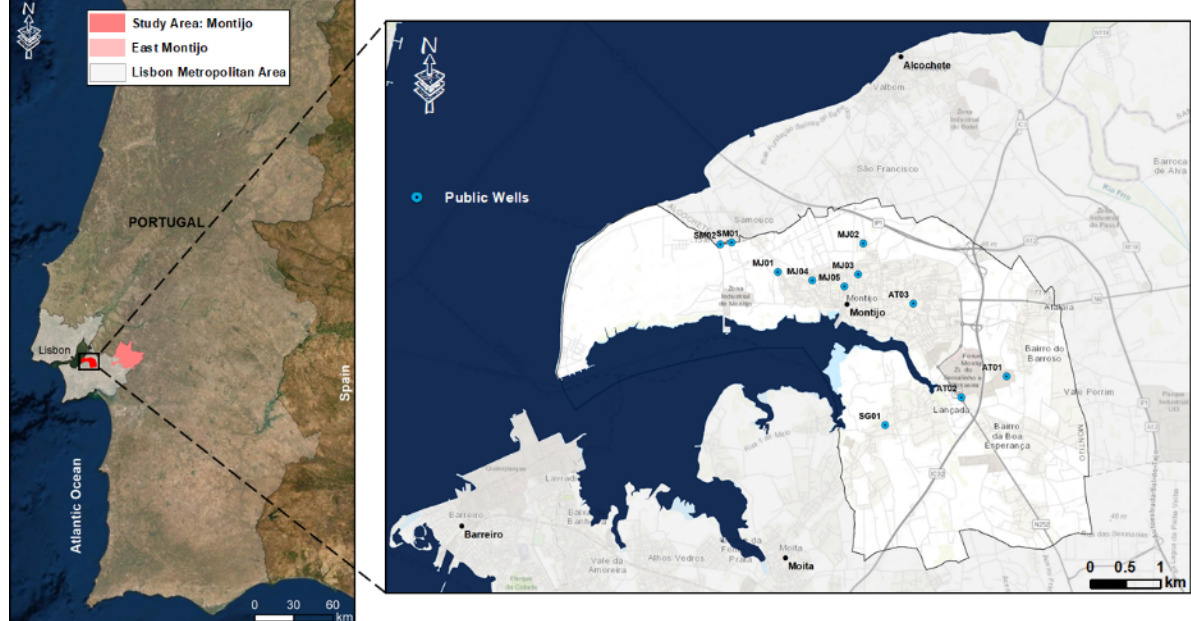
Figure 1. Geographical framework of the study area and location of the public wells supply.